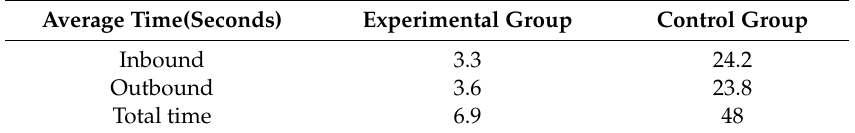
Figure 8. The RFID readers at storage room and manufacturing area.